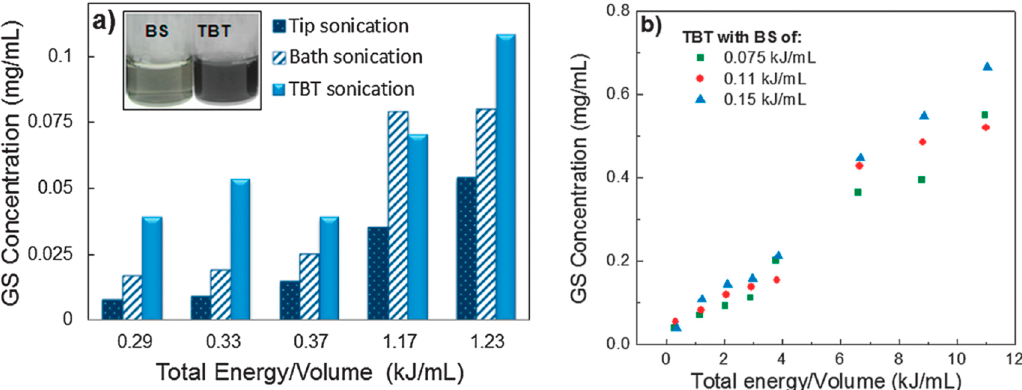
Figure 20. Optimization of sonication procedure, dispersant and energy/volume. ( a ) GS concentrations upon bath sonication (BS), tip sonication (TS) and tip-bath-tip sonication (TBT). Inset: image of the supernatant of the GS dispersions after centrifugation; ( b ) concentration of graphene sheets (with TX-100) as a function of integrated sonication energy/volume. These solutions were treated by TBT cycles. Reproduced from [50]. Copyright Owner Societies, 2013.